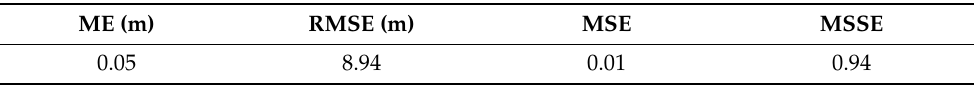
Table 3. Cross-validation results for the total soil thickness estimates using EBK